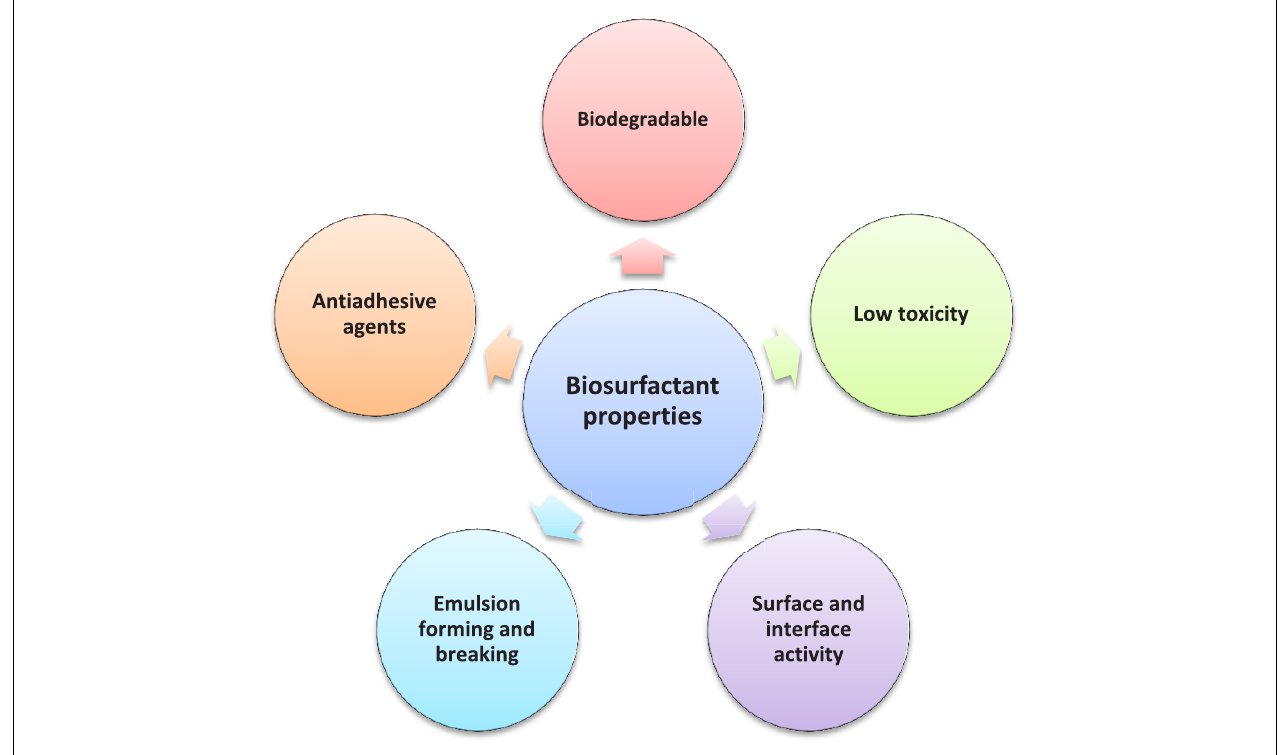
FIGURE 3 | Highlighting the properties of biosurfactants as an economical approach for remediation of